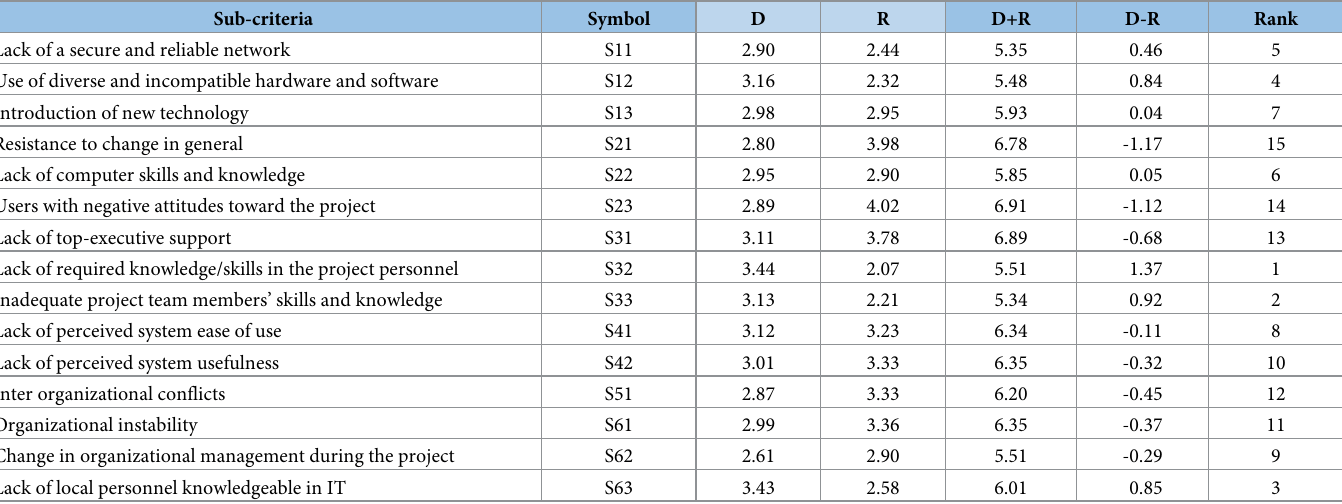
Table 9. Internal relationships of the sub-criteria. Sub-criteria